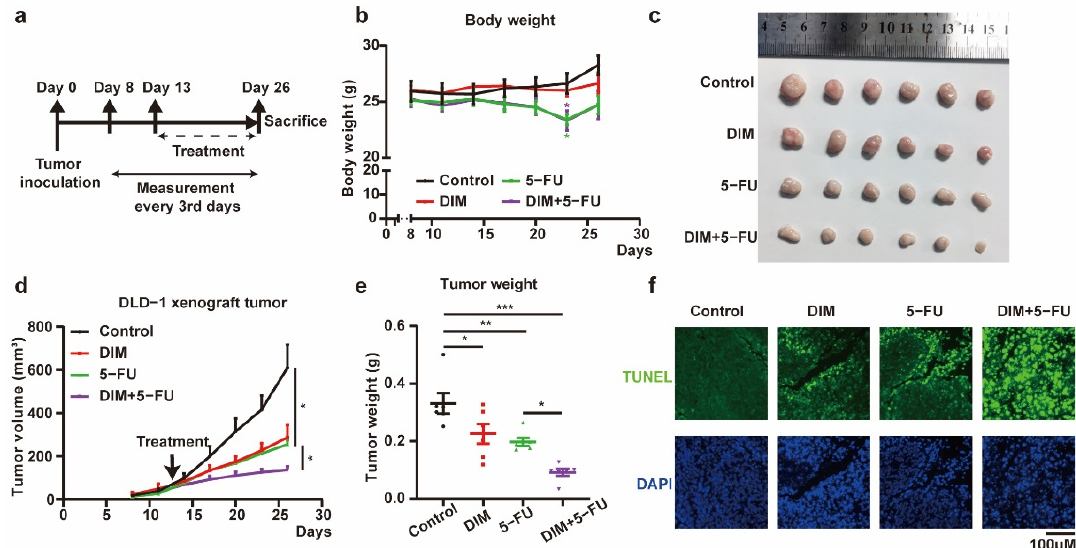
Figure 5. DIM enhances 5-FU-based chemotherapy effects in vivo. ( a ) Schematic overview of in vivo experiment. Tumor volumes and body weights were measured every three days from the eighth day after tumor inoculation. Intraperitoneal injection 6 times with DIM (40 mg/kg, 10%DMSO) and 3 times with 5-FU (40 mg/kg, PBS) from the thirteenth day after tumor inoculation. ( b ) Representative images of tumor in control ( n = 6), DIM ( n = 6), 5-FU ( n = 6), and DIM + 5-FU ( n = 6) groups were plotted. ( c ) Measured body weights of mice in control, DIM, 5-FU, and DIM + 5-FU groups. ( d ) Tumor growth curves comparing control, DIM, 5-FU, and DIM + 5-FU DLD-1 xenograft every three days were plotted. ( e ) Corresponding tumor weights in control, DIM, 5-FU, and DIM + 5-FU groups were plotted. ( f ) Xenograft tumor sections were fixed to analyze the apoptotic cells (green) by TUNEL staining (green). Representative images are shown. Scale bar: 100 μ m. Data are presented as mean ± SEM. *, p < 0.05; **, p < 0.01; ***, p < 0.001; Two-way ANOVA test.